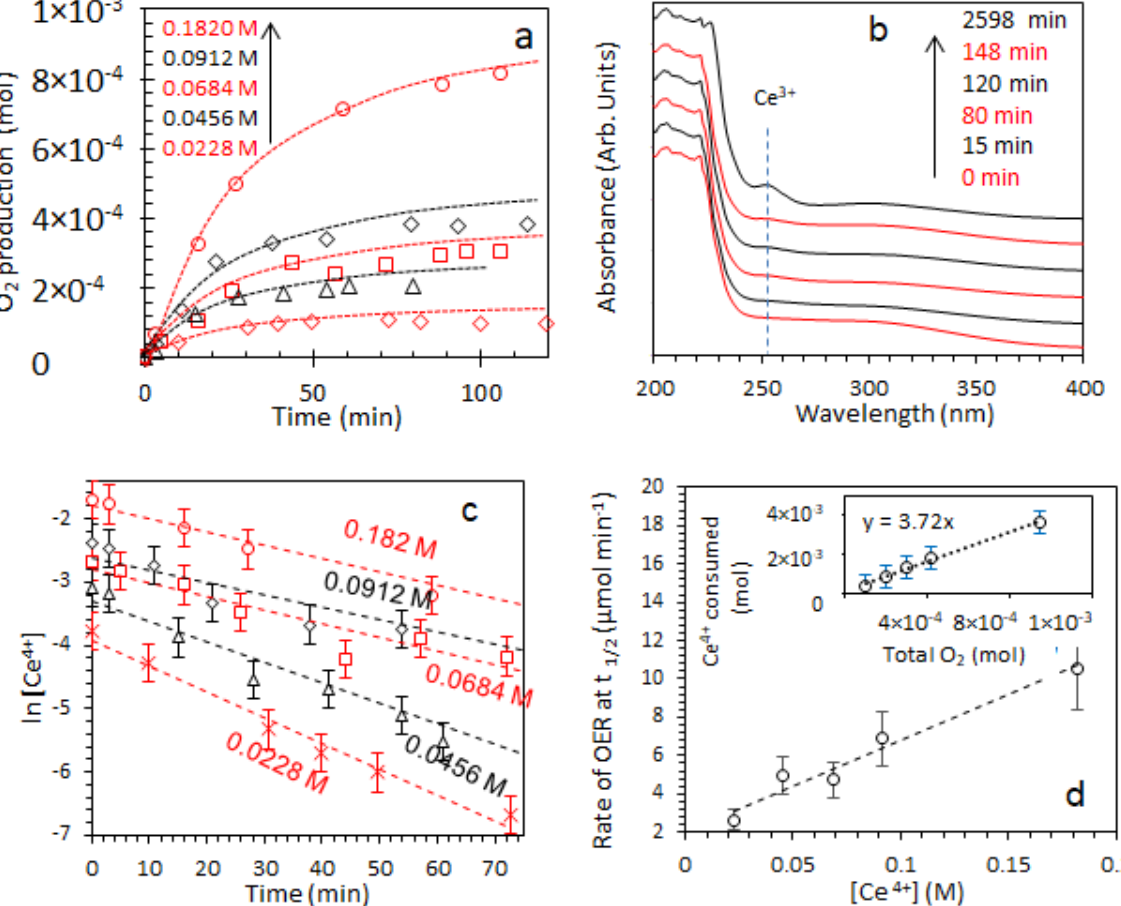
Figure 9. Reaction kinetics of water oxidation over 1 wt.% Ir on TiO 2 anatase at different reaction times and [Ce 4+ ] concentrations. ( a ) Effect of [Ce 4+ ] on O 2 production. ( b ) UV-Vis absorbance spectra monitoring the reduction of Ce 4+ to Ce 3+ during OER. ( c ) Computed Ce 4+ cation concentration (where Ce 4+ cations at time t , [Ce 4+ ] t , is equal to Ce 4+ cations at time zero, [C 4+ ] 0 , minus Ce 3+ cations at time t , [Ce 3+ ] t ) as a function of time. ( d ) Ln [Ce 4+ ] as a function of time up to ca. 70 min. ( d ) Rate of OER as a function of [Ce 4+ ] at time t 1/2 (where t 1/2 is the time at which 50% of Ce 4+ was consume); the inset presents a plot of the total moles of Ce 4+ cations as a function of the total moles of O 2 (a slope of 3.72 was obtained; the theoretical slope should be 4).